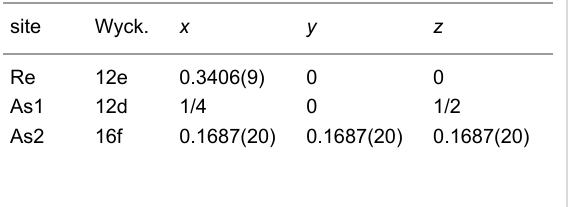
Table 4: Re 3 As 7 crystallographic data used for electronic-structure calculations